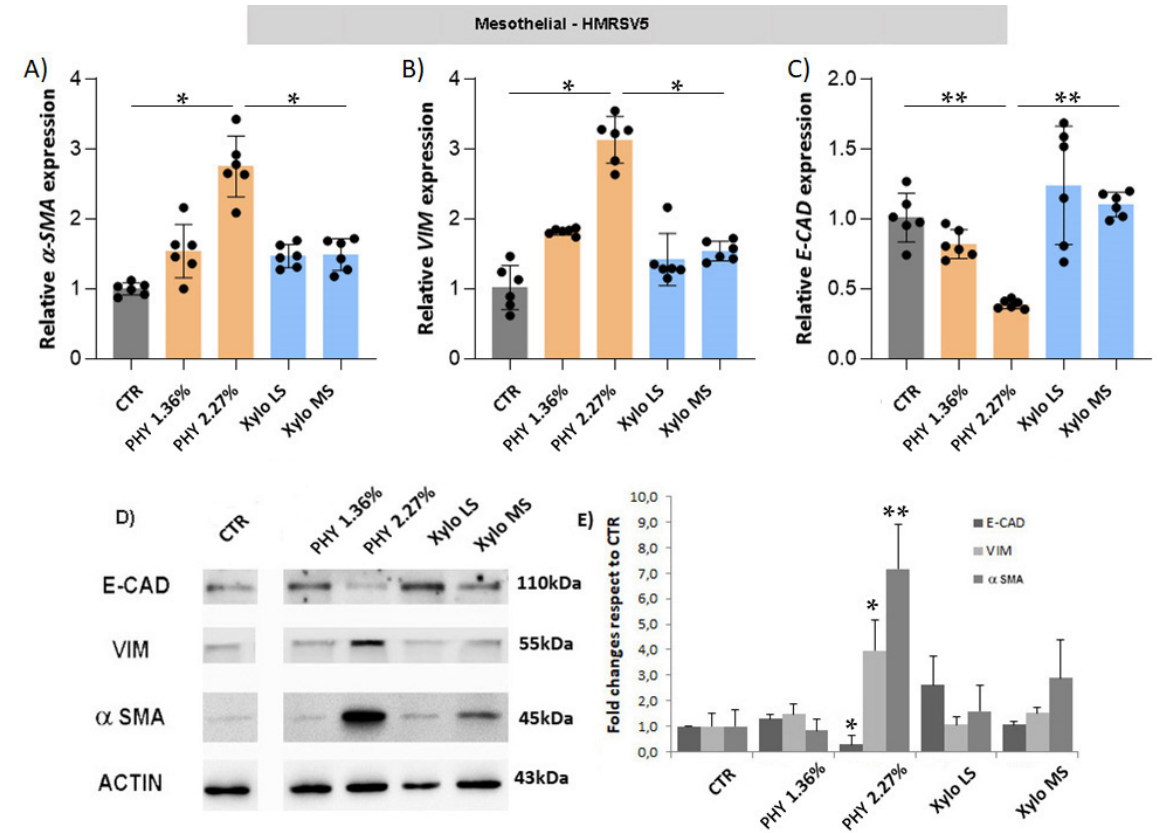
Figure 6. Expression of epithelial and mesenchymal markers in mesothelial cells. α -SMA ( A ), VIM ( B ) and E-CAD ( C ) gene expression. The analysis was performed in HMRSV5 mesothelial cells as described in Figure 5. ( n = 6 biological replicates) ( A ) CTR vs. PHY 2.27% p = 0.0212, PHY 2.27% vs. Xylo MS p = 0.0173; ( B ) CTR vs. PHY 2.27% p = 0.0169, PHY 2.27% vs. Xylo MS p = 0.0033; ( C ) CTR vs. PHY 2.27% p = 0.0002, PHY 2.27% vs. Xylo MS p < 0.0001 ( D ) The protein expression of E-CAD, α -SMA and VIM was evaluated by Western Blot analysis. ACTIN was included as loading control. ( E ) WB quantification expressed as fold changes of bands intensity, normalized to ACTIN, respect to CTR ( n = 3 biological replicates). Graph represent mean ± standard deviation (error bars). * p < 0.05, ** p < 0.001.